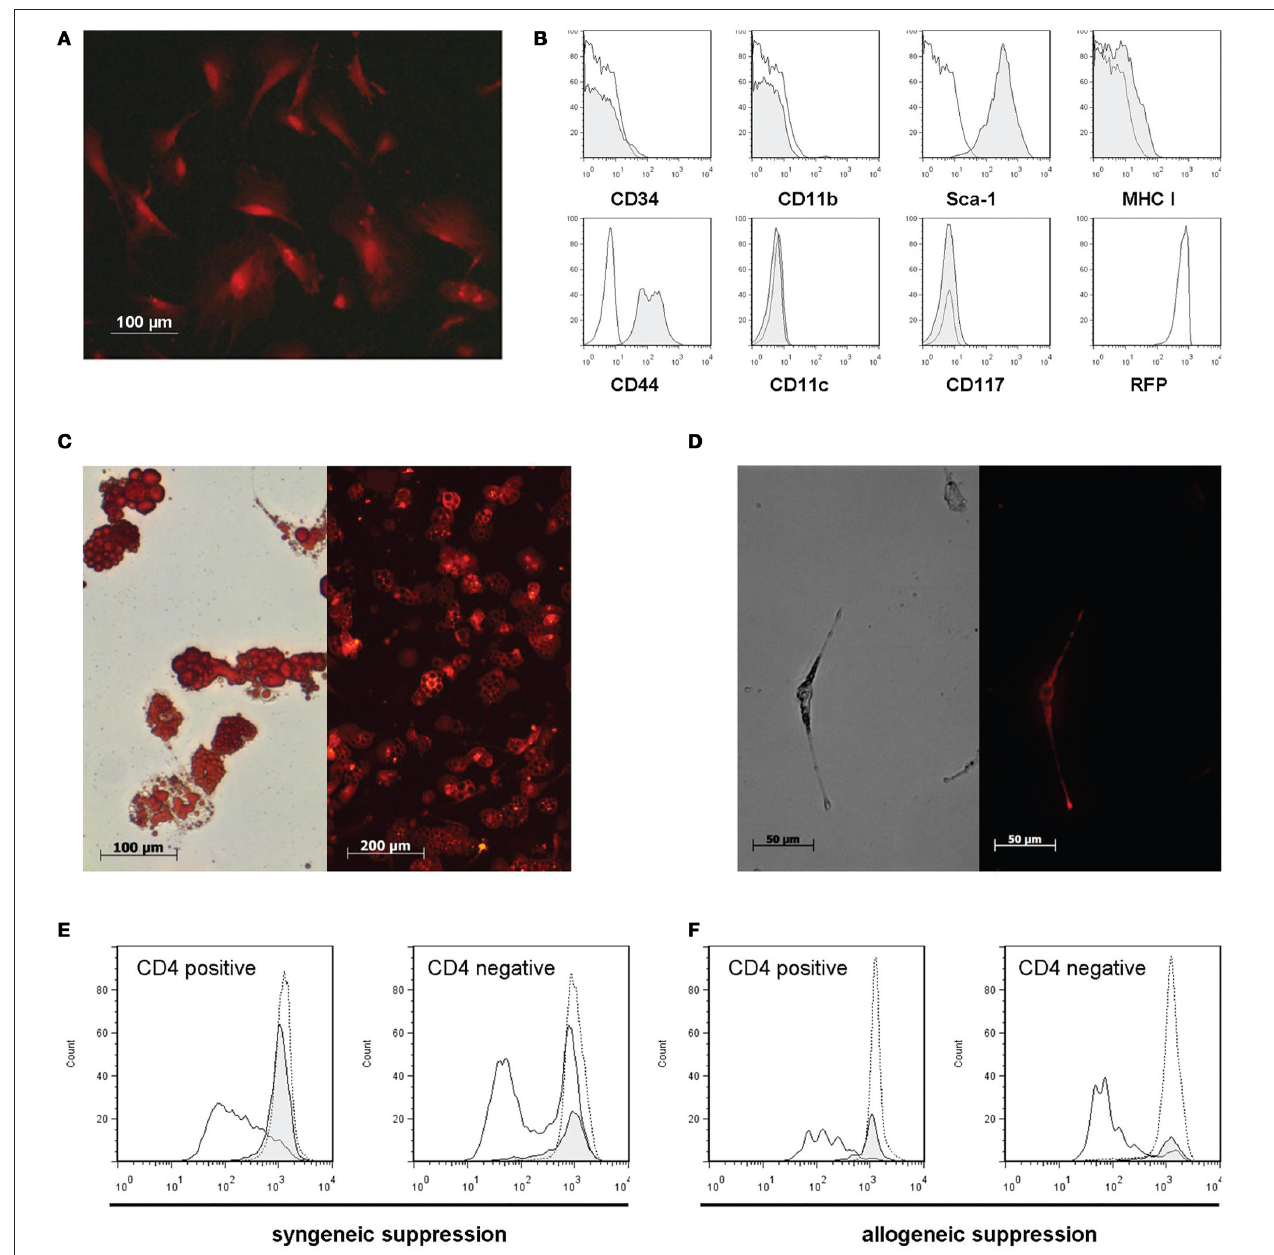
FIGURE 1 | DsRed-MSC are phenotypically and functionally comparable to wild-type MSC. (A) Fluorescence microscopy of plastic adherent DsRed-MSC in culture shows bright red fluorescence. (B) Flow cytometric analysis demonstrates that DsRed-MSC are negative for the expression of CD34, CD11b, CD11c, and CD117, show weak expression of MHC class I, and are positive for Sca-1, CD44, and RFP (DsRed). (C) DsRed-MSC are capable of differentiating into adipocytes, as demonstrated by staining of lipid vesicles by Oil-Red-O (left), while remaining red fluorescent (right). (D) DsRed-MSC are